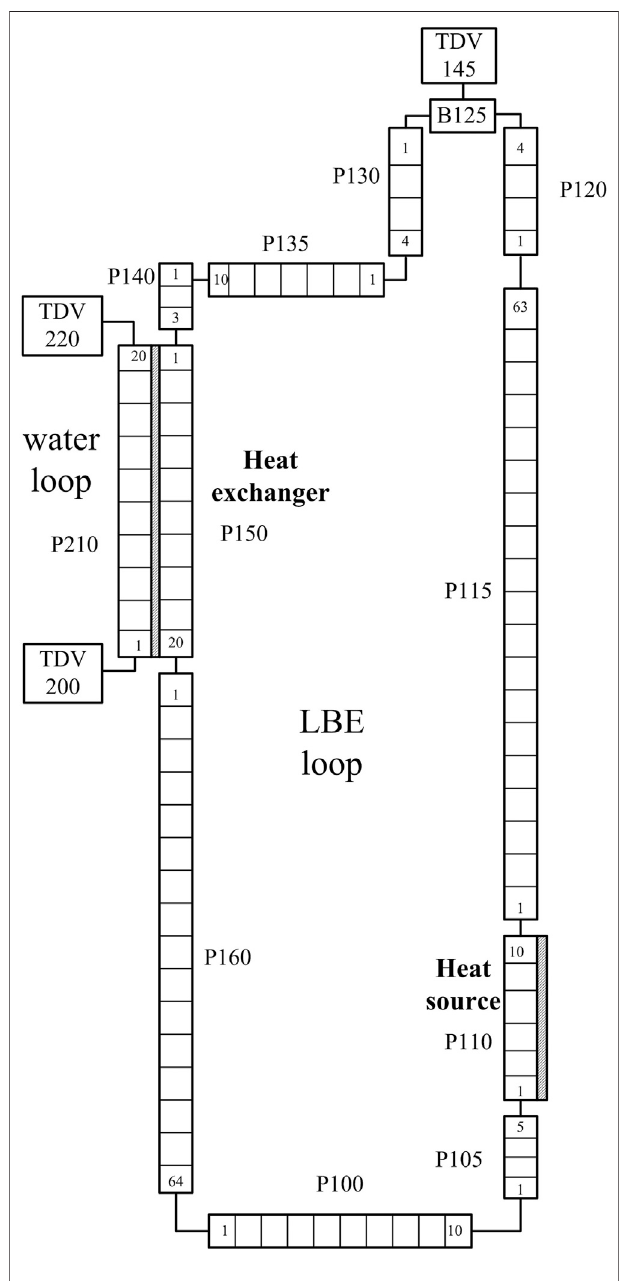
FIGURE 4 | NACIE facility nodalization.